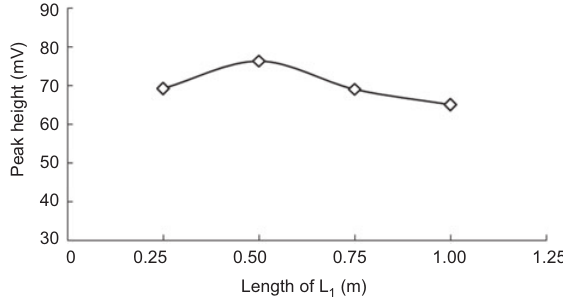
Figure 6 Effect of the ERB concentration.